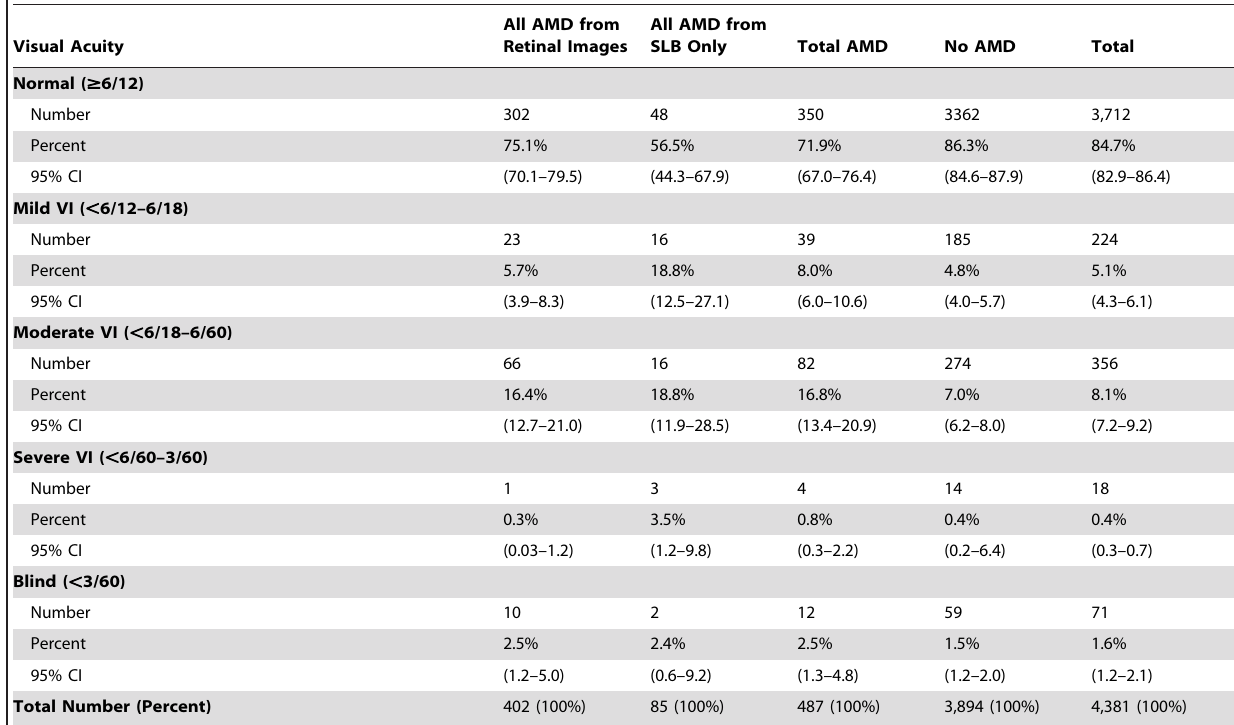
Table 8. Visual acuity in those with AMD.